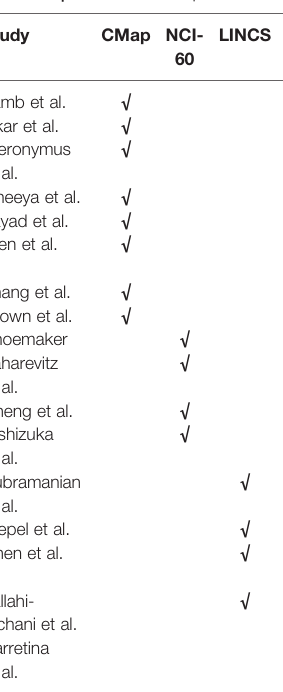
TABLE 4 | Reverse transcriptome change – based